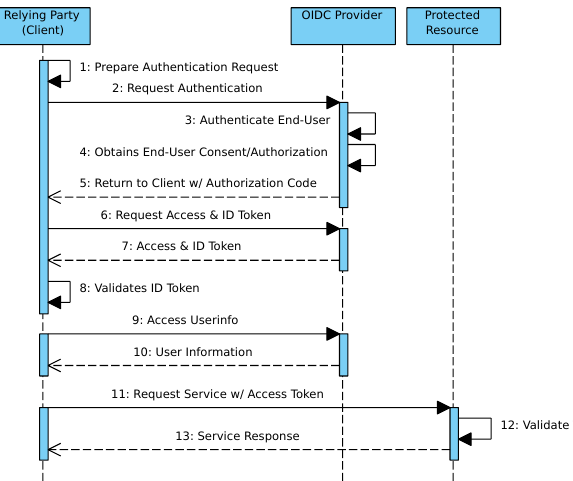
Fig. 4: OpenID Connect authentication